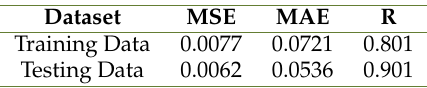
Table 1. ANN-3-7-1 model performance.